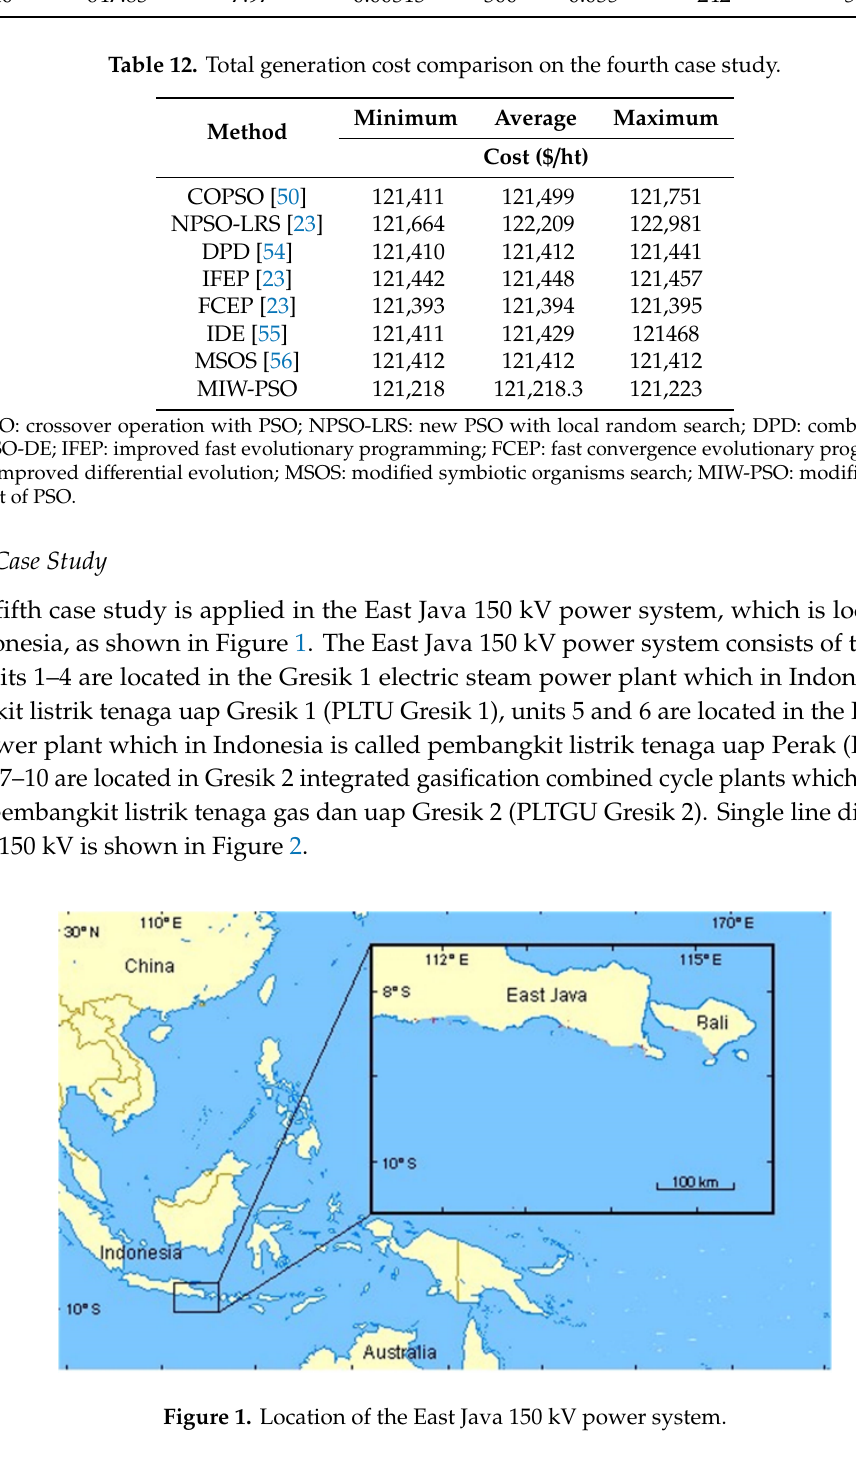
Figure 2. Single line diagram of the East Java 150 kV power system. The input data used in the fifth case study are shown in Table 13. Moreover, MIW-PSO is applied with total demand 616 MW. In this case study, the MIW-PSO is used to solve ED problems with smooth cost function. Using PSO obtain total cost 95,840.57 $ h⁄ . However, MIW-PSO gets 95,835.53 $ h⁄ for total cost, as written in Table 14. MLIWANG